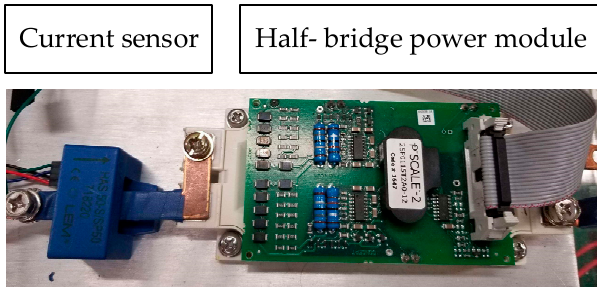
Figure 7. HBPM integrated with current sensor.